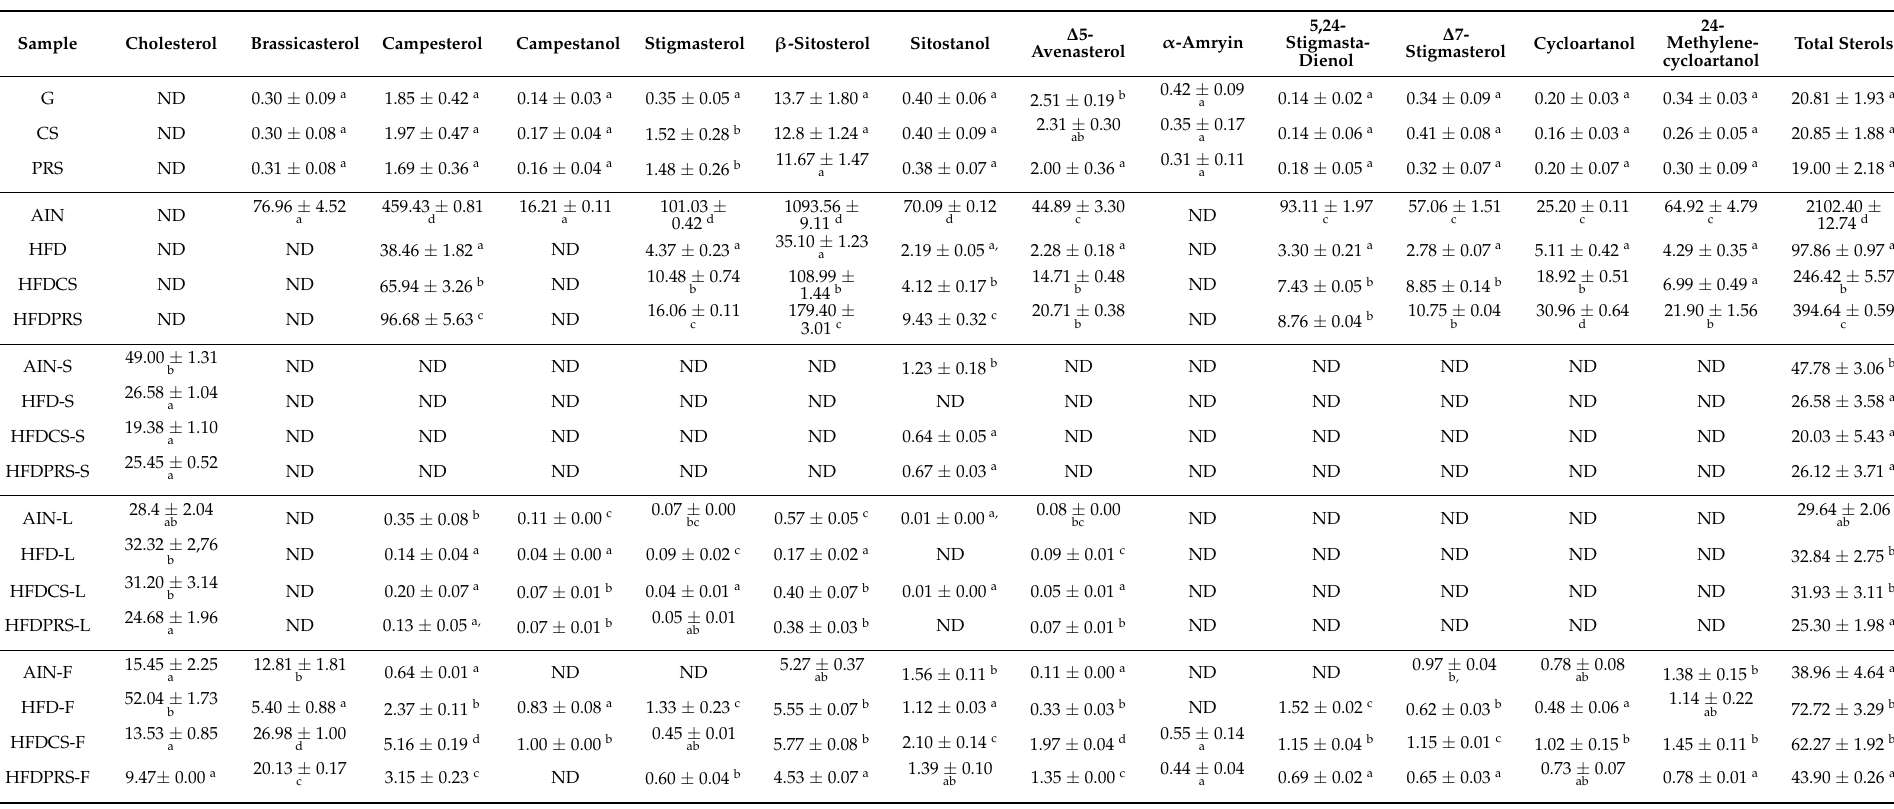
Table 3. The content of sterols in buckwheat seeds (mg/g lipids) and sprouts (mg/g lipids), experimental diets ( µ g/g lipids), serum ( µ g/100 µ L serum), liver (mg/g lipids) and feces (mg/g